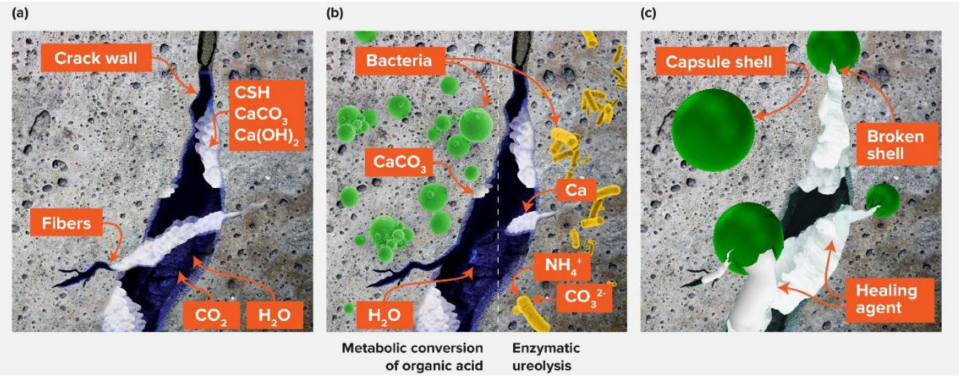
Figure 6. Self-healing mechanisms: ( a ) autogenous, ( b ) autonomous bacteria-based, and ( c ) au- tonomous capsule-based (Adapted with permission from IOP [139]).